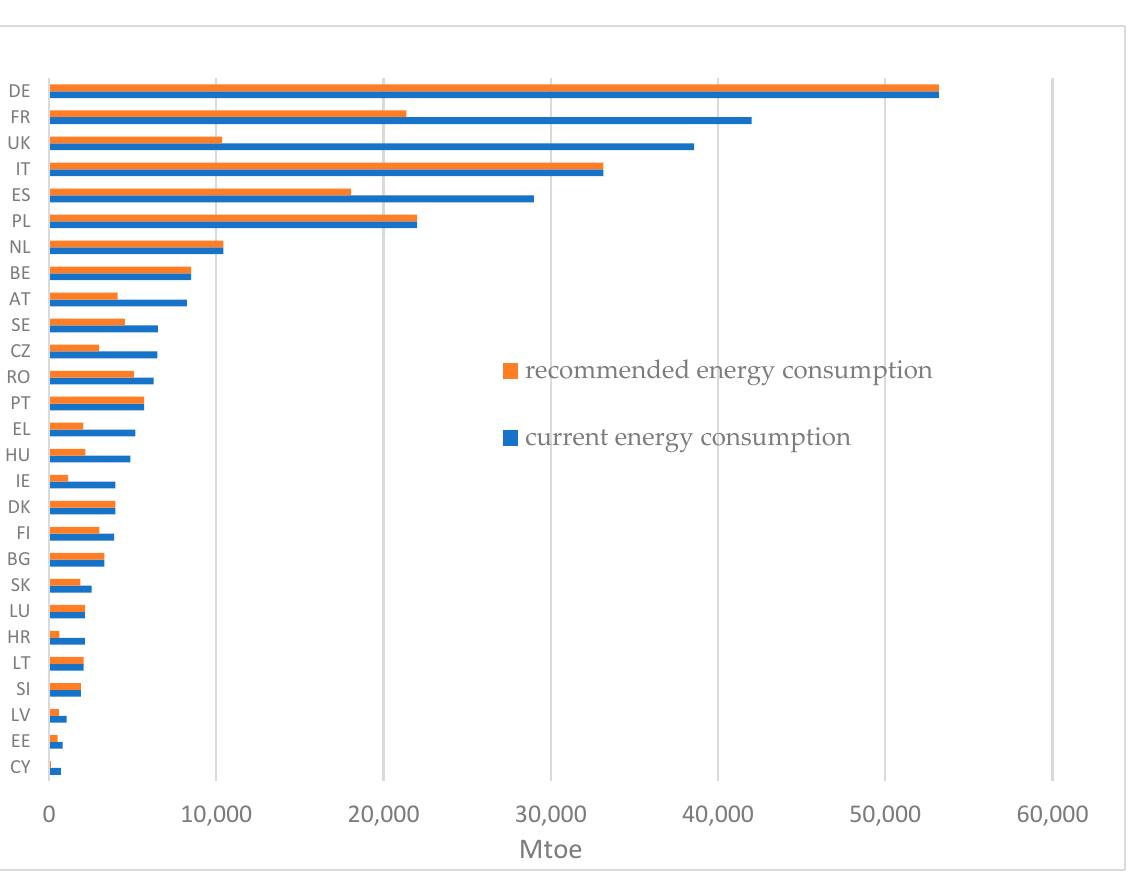
Figure 14. Final consumption of energy by road freight transport sector in the EU (2019, Mtoe). Source: Own elaboration.